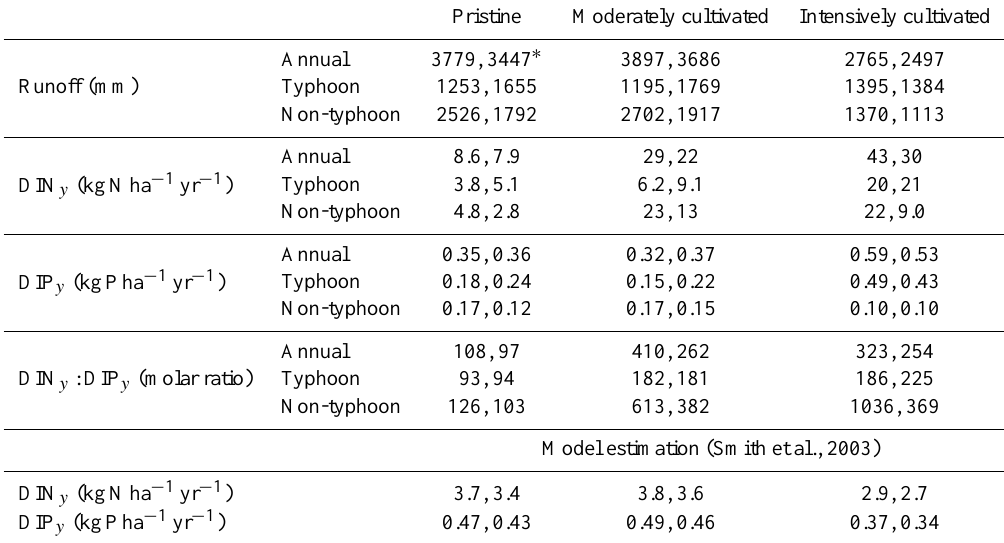
Table 4. Different time frames (annual, typhoon, and non-typhoon period) of the observed runoff, calculated DIN yield (DIN y ), DIP yield (DIP y ) and DIN y :DIP y ratios for the three study watersheds. DIN y and DIP y estimated by the model proposed by Smith et al. (2003) are also in the table. Pristine Moderately